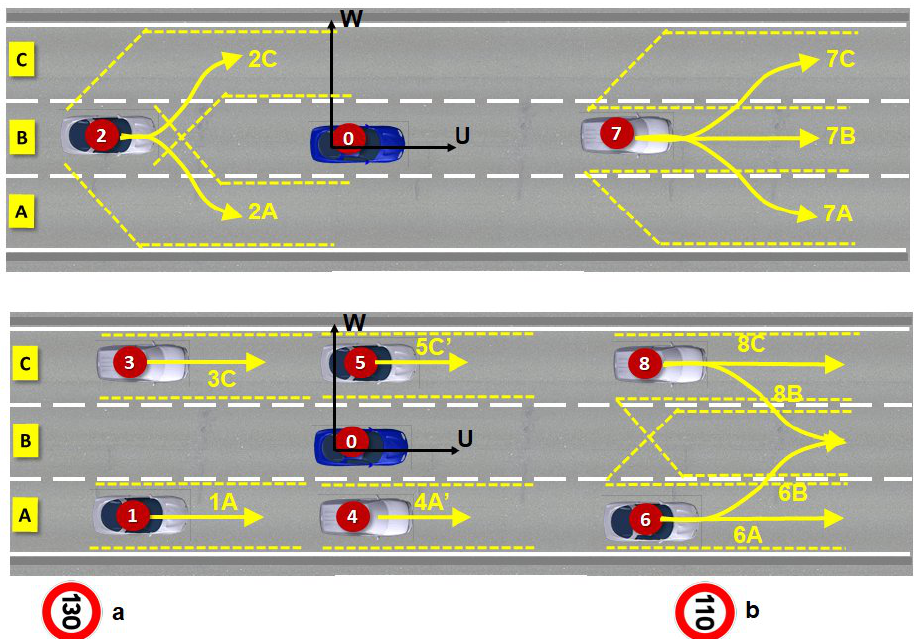
Figure A3. Prediction of possible trajectories for objects 1 to 8 depending on their position relatively to the ego-vehicle and traffic